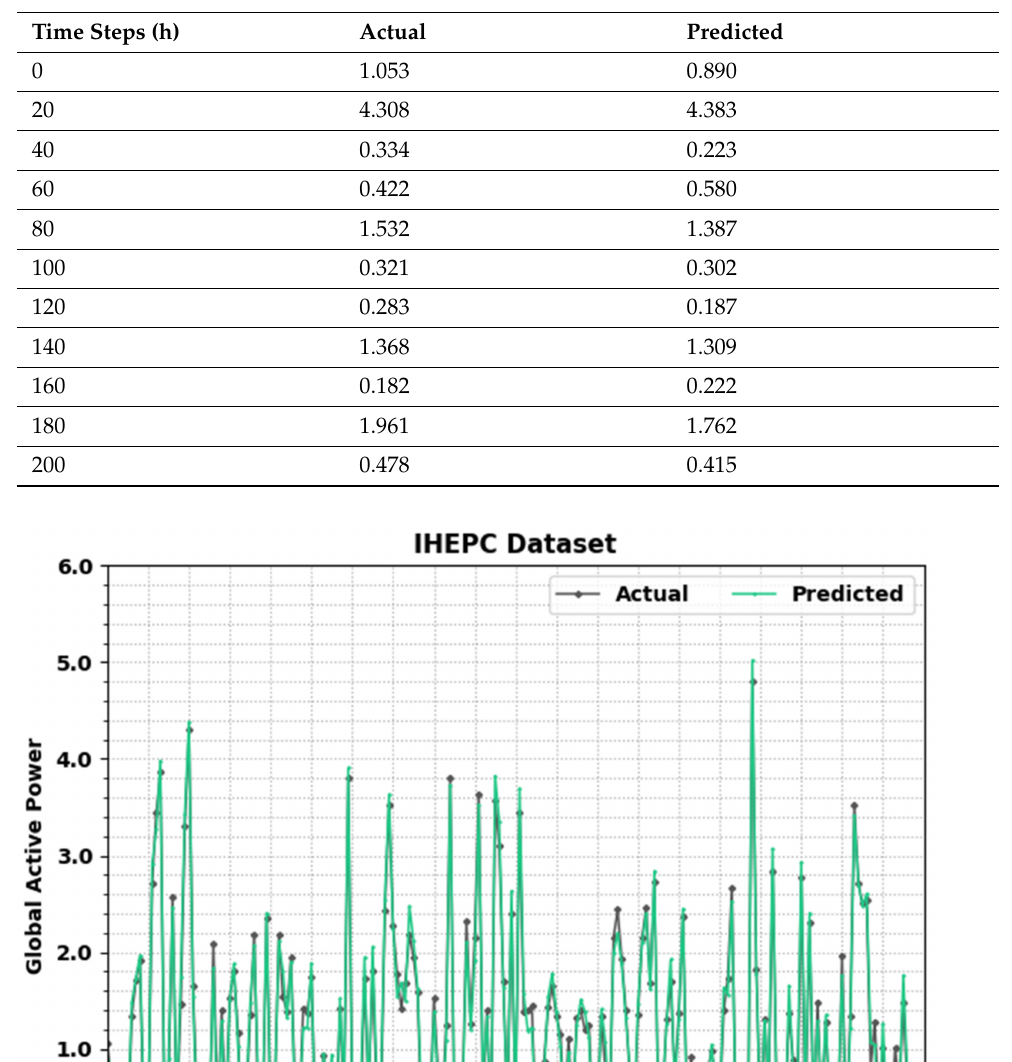
Table 2. Global active power analysis of AJODL-DSSEM technique under distinct time steps on IHEPC dataset.